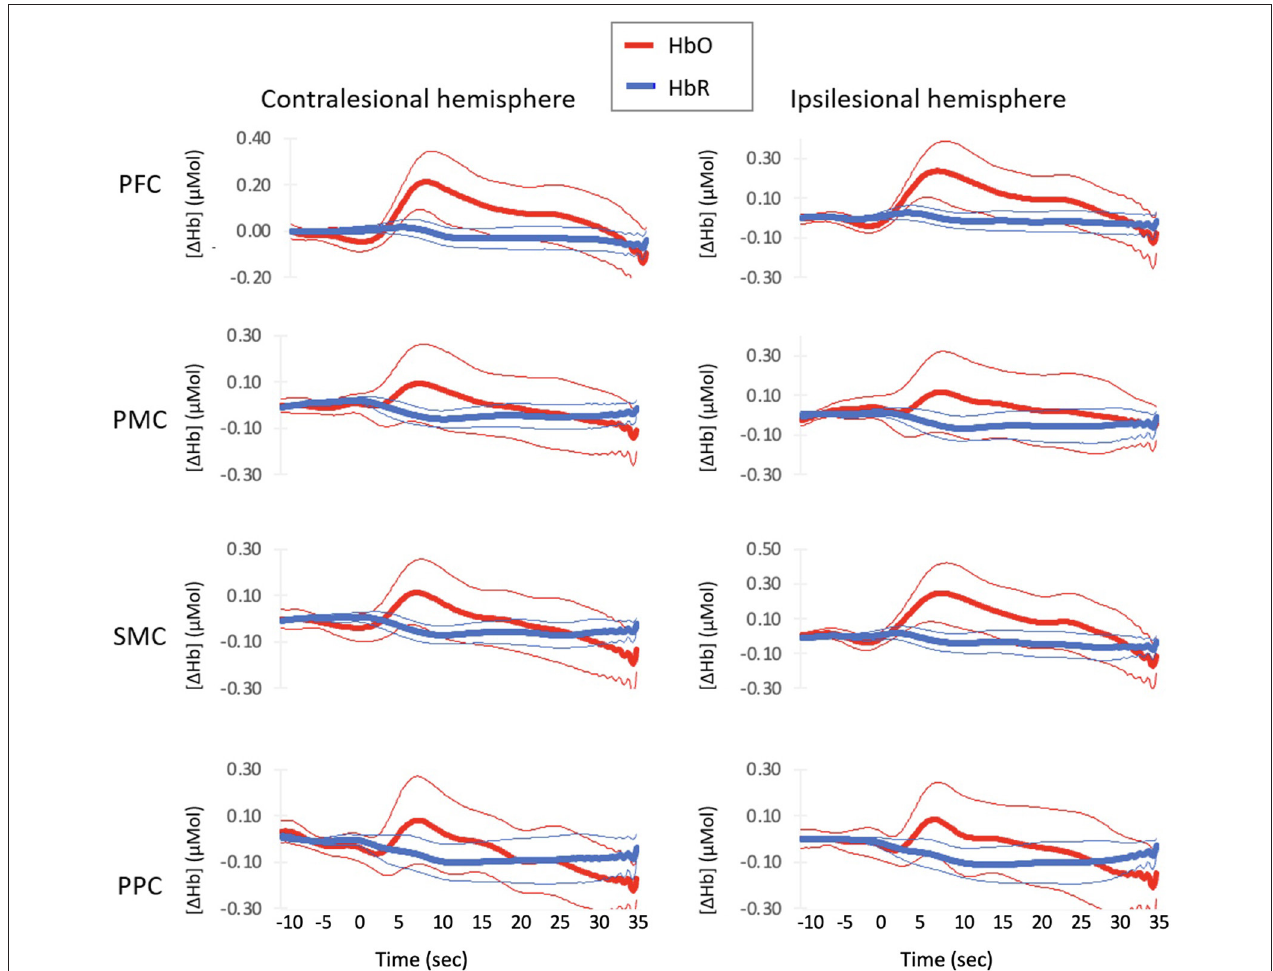
FIGURE 2 | Average Hemodynamic Responses with Normal–paced Walking for each region of interest. Thick lines indicate group mean response and thin lines indicates 2 standard errors around the